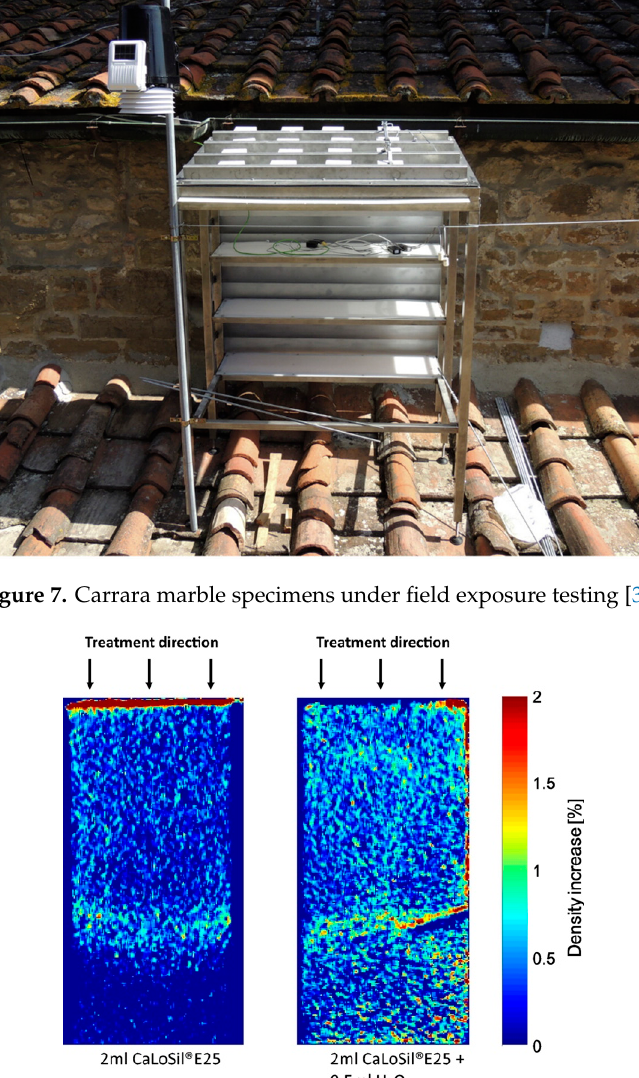
Figure 8. X-ray radiographic images of samples treated with CaLoSiL® (left) and CaLoSiL® and immediately water (right) [48].